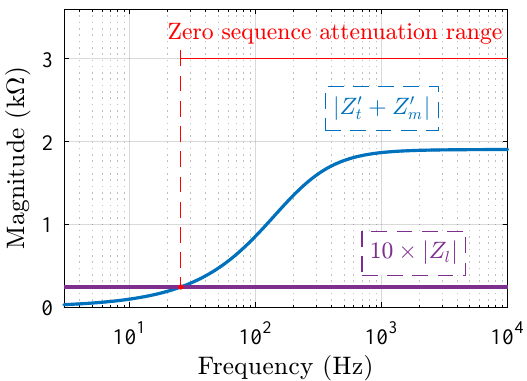
Figure 7. Evaluation of the zero sequence attenuation range for resistive loads ( | Z l | = Z base and PF = 1). Analysis for S x opened: attenuation range > 25